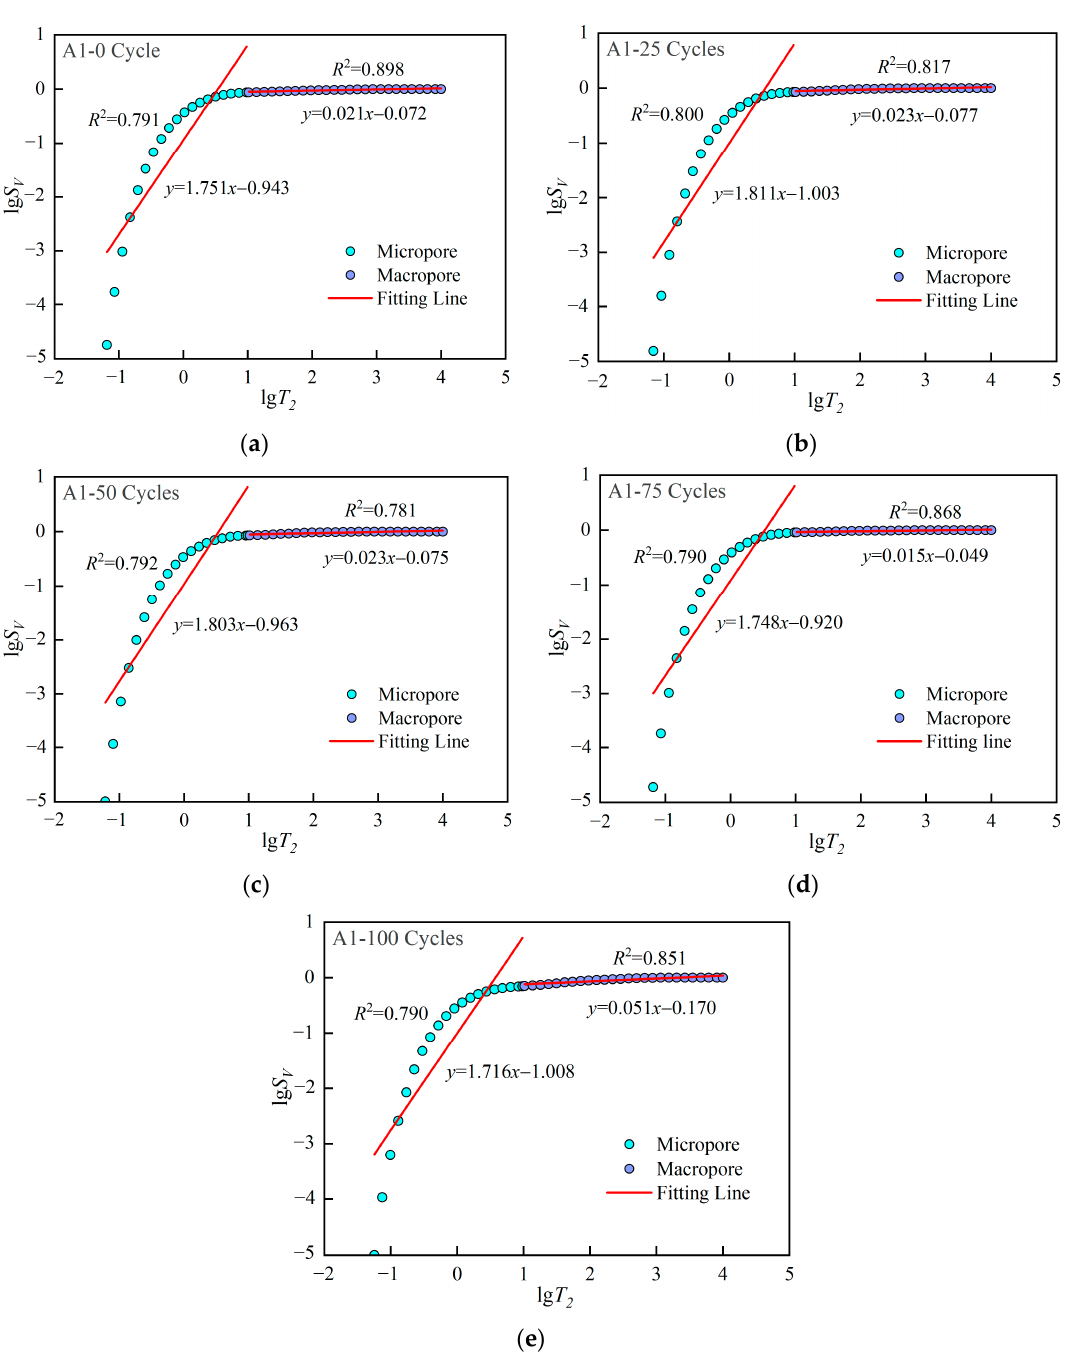
Figure 8. NMR fractal characteristics of samples in group A1. Table 3. NMR fractal dimension.